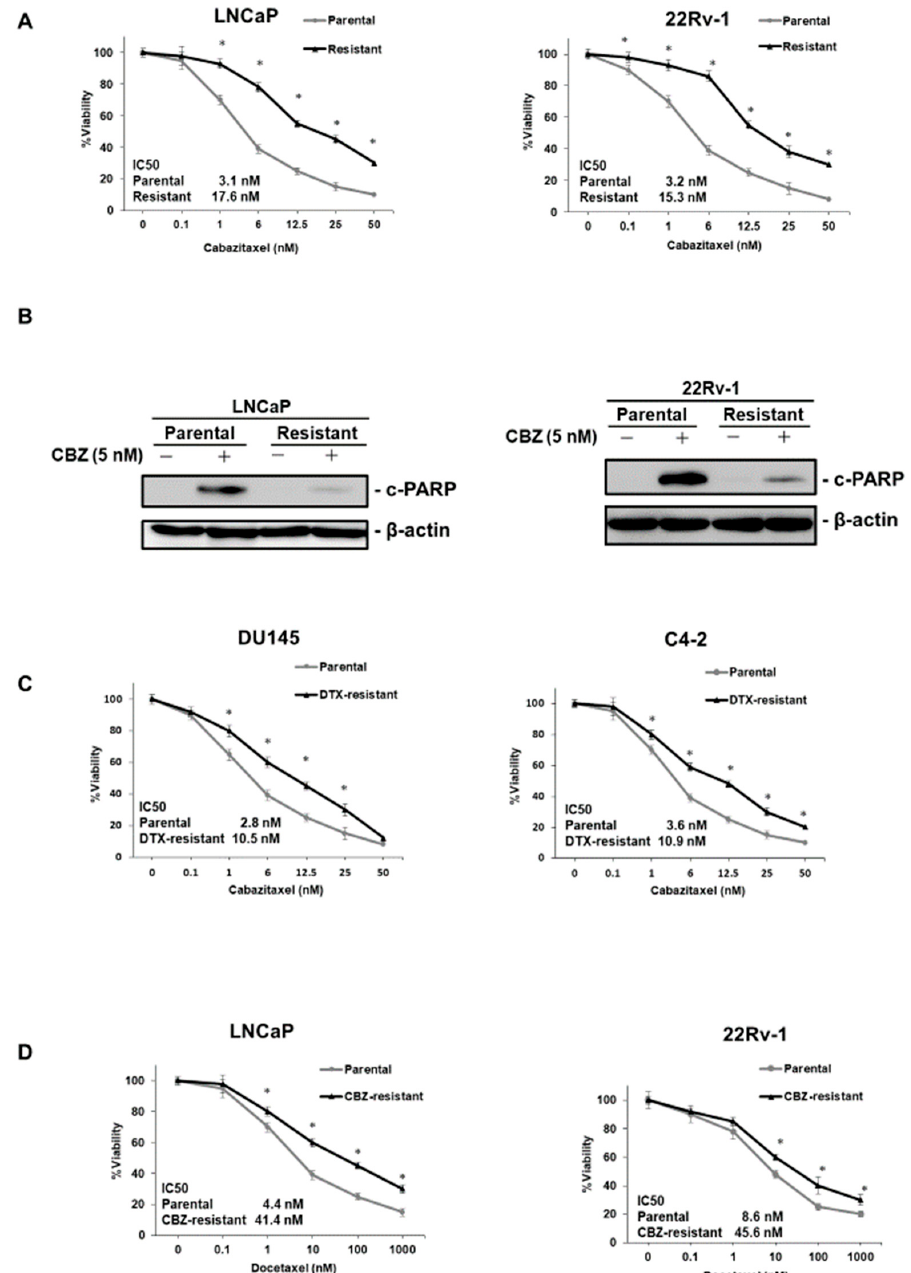
Figure 1. Characterization of cabazitaxel (CBZ)-resistant prostate cancer cell lines. ( A ) The dose-dependent effects of CBZ on the cell viability of parental and CBZ-resistant cell lines in LNCaP and 22Rv-1 cells. The results are expressed as the mean and standard deviation (SD) of triplicate measurements. * p < 0.01. ( B ) Western blotting of c-PARP in parental and CBZ-resistant cell lines in LNCaP and 22Rv-1 cells in the presence of CBZ (5 nM) or vehicle (ethanol). β -actin was used as a loading control. c-PARP: cleaved PARP. ( C ) The dose-dependent effects of CBZ on the cell viability of parental and docetaxel (DTX)-resistant cell lines in DU145 and C4-2 cells. The results are expressed as the mean and SD of triplicate measurements. * p < 0.01. ( D ) The dose-dependent effects of DTX on the cell viability of parental and CBZ-resistant cell lines in LNCaP and 22Rv-1 cells. The results are expressed as the mean and SD of triplicate measurements. * p < 0.01.